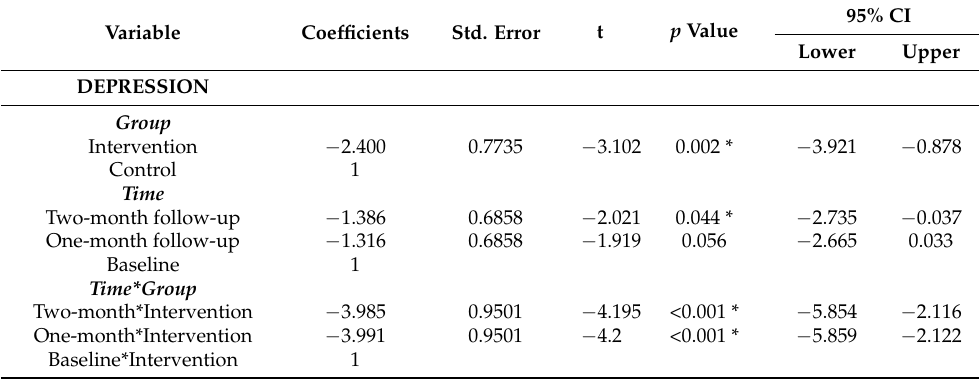
Table 5. The effect of IMB-based health education on depression, anxiety, and stress scores between the intervention and control